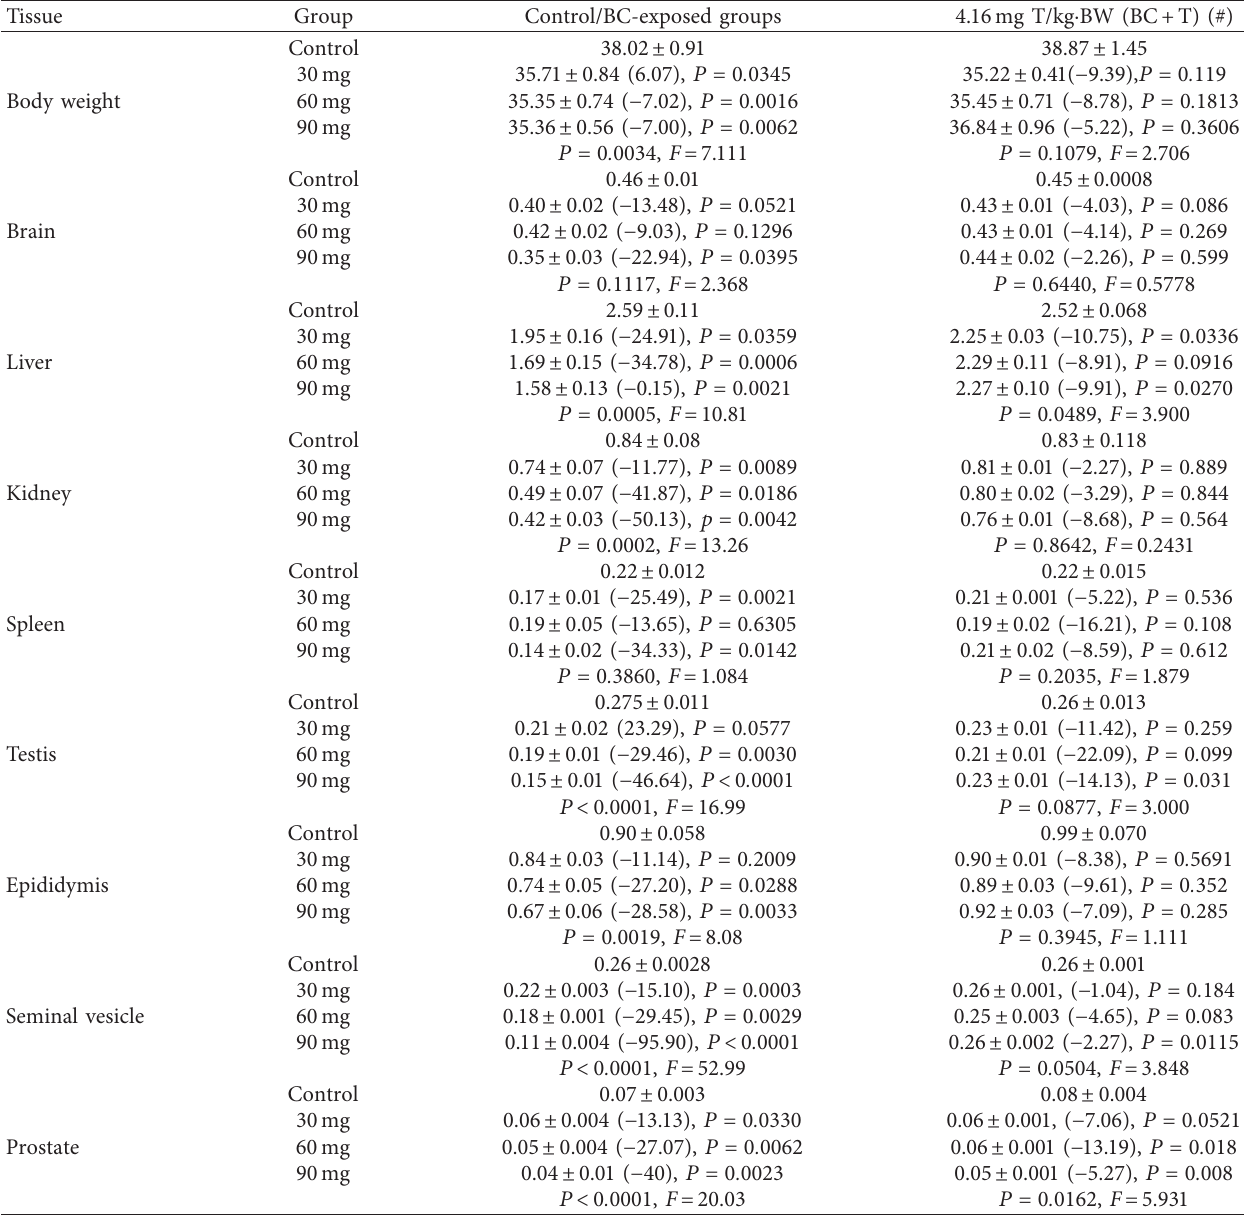
Table 2: Administration of testosterone (T) on body weight (gm) and tissue indices (W/W%) of adult male mice exposed to baicalein (BC)